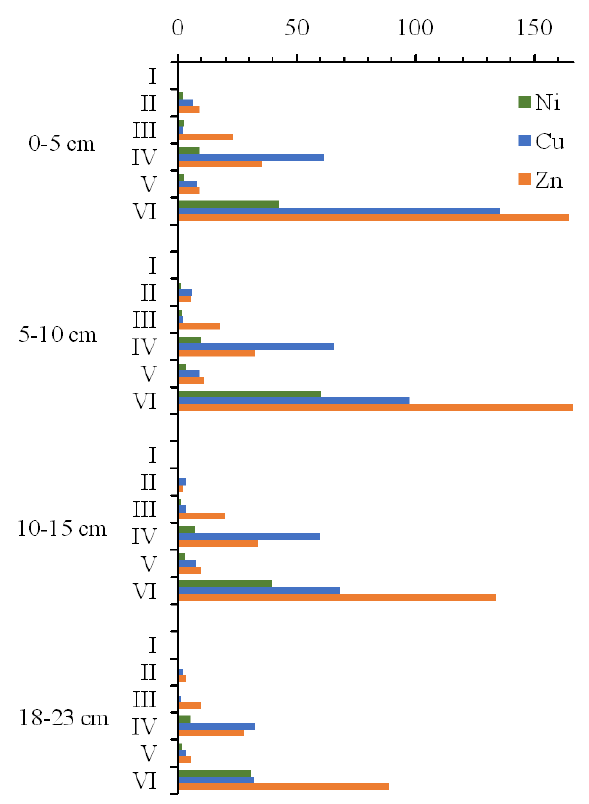
Figure 13. Concentrations (µg/g) of various forms of Ni, Cu, and Zn in the sediments (layers 0 – 5, 5 – 10, 10 – 15, and 18 – 23 cm) of Lake Bolshoy Vudjavr, forms: I — water-soluble forms, II — exchangeable cations (mobile forms), III — forms associated with Fe and Mn hydroxides, IV — forms associated with organic matter, V — acid-soluble forms, and VI — mineral forms.